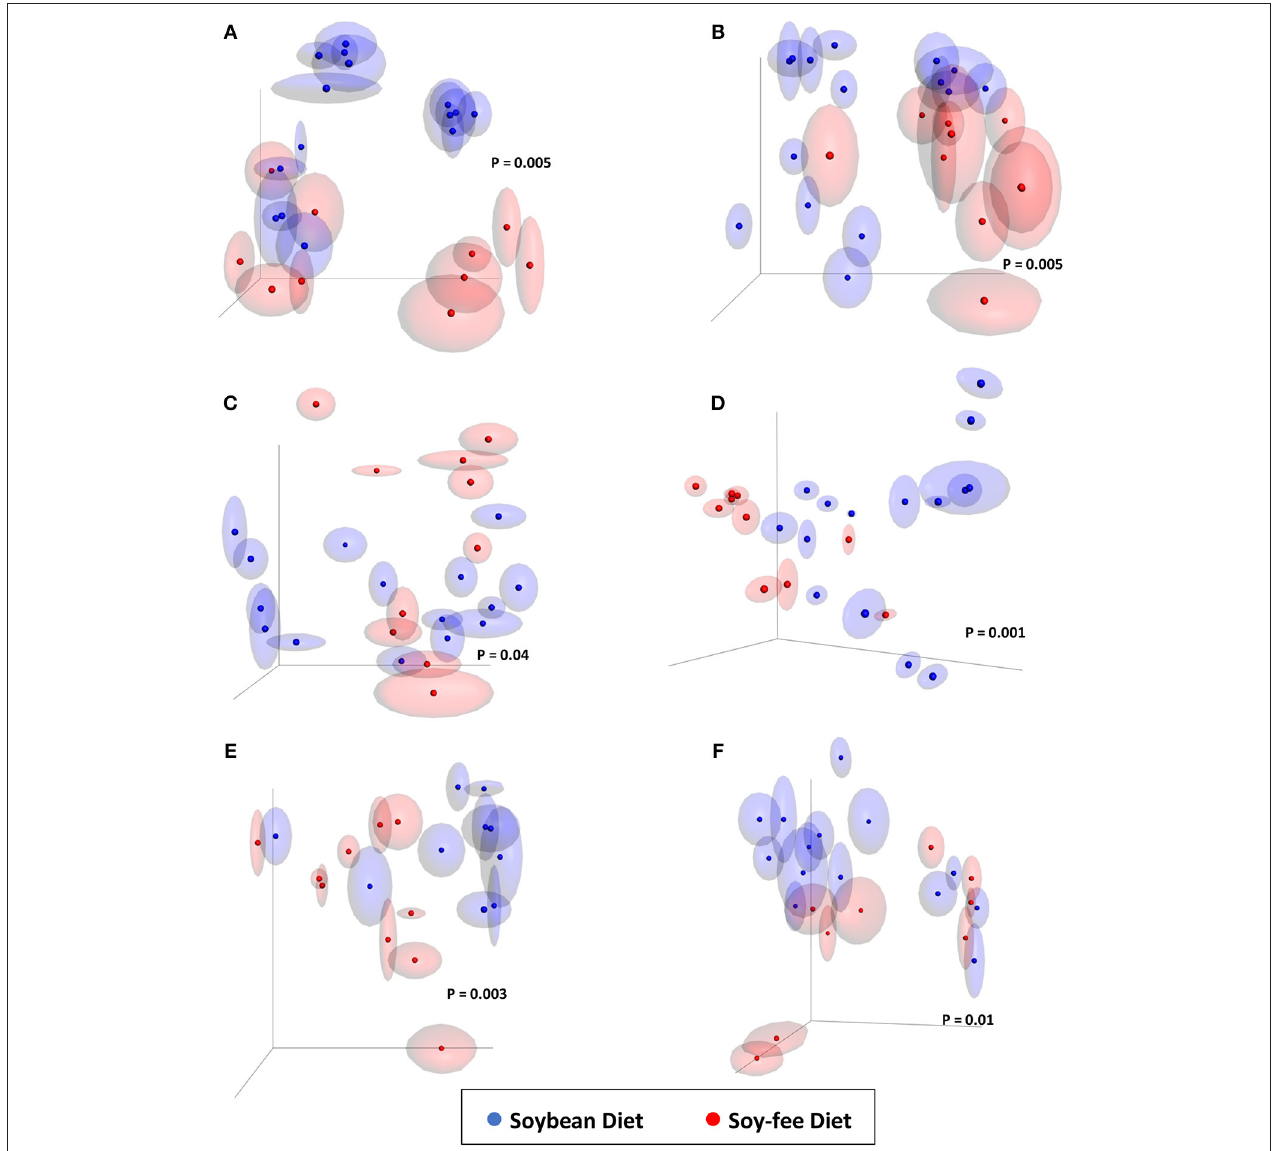
FIGURE 4 | Jackknifed 3D principal coordinate analysis (PCoA) of β -diversity of broilers fed SB or SF diets using unweighted UniFrac distances. (A) 4-week-old feces; (B) 7-week-old feces; (C) 12-week-old feces; (D) Processing cecal contents; (E) Processing WCR; (F) Final Product WCR. P -values based on PERMANOVA analyses shown within each graph. Halos around the data points represent 95% confidence